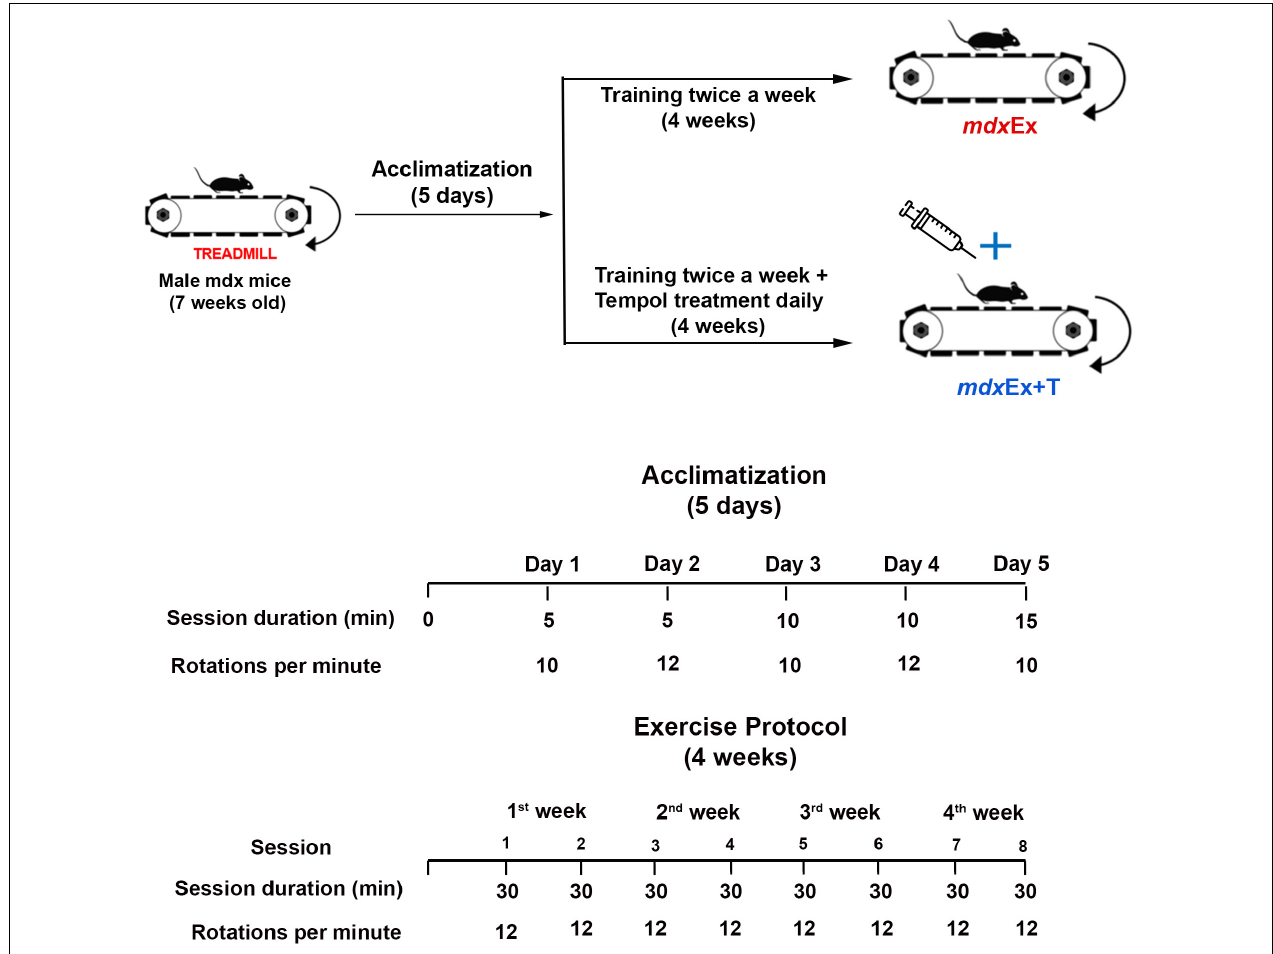
FIGURE 1 | Exercise protocol and Tempol